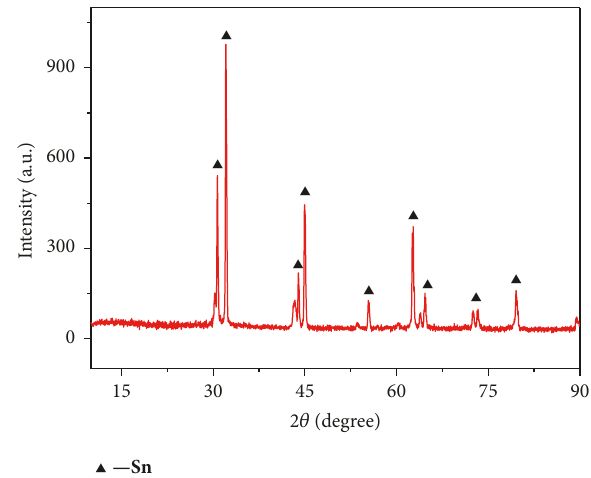
Figure 9: XRD patterns of tin deposits obtained on glassy carbon electrode from the [Bmim]HSO 4 /H 2 O mixture (30% H 2 O, v/v) solution containing 40mM SnO at -0.6 V and